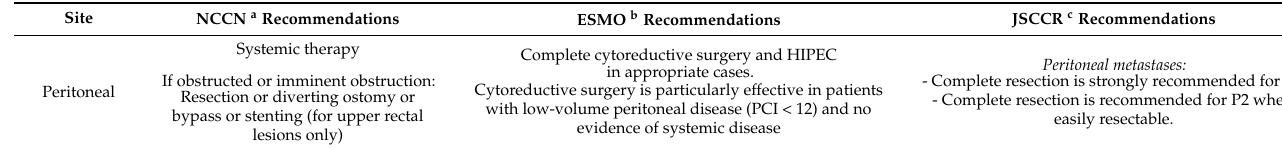
Table 8. Management of metastatic rectal